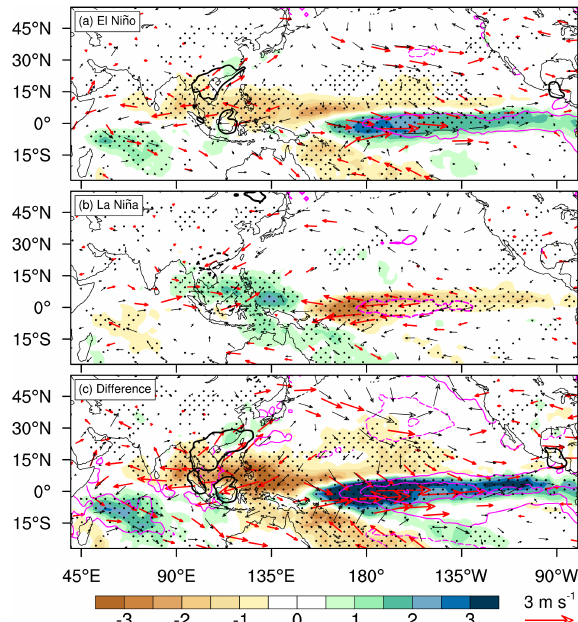
Figure 5. Same as Fig. 4, except for SST anomalies (purple con- tours with interval of 0.05 ◦ C; the dashed contours are for negative values, and the zero contour is omitted for clarity), precipitation anomalies (shading; mmd − 1 ), and 850hPa wind anomalies (black vector; ms − 1 ). Black contours are the same as those in Fig. 4. Stip- pling and red vectors indicating the anomalies of precipitation and wind are statistically significant at the 95% confidence level based on the Student’s t test,